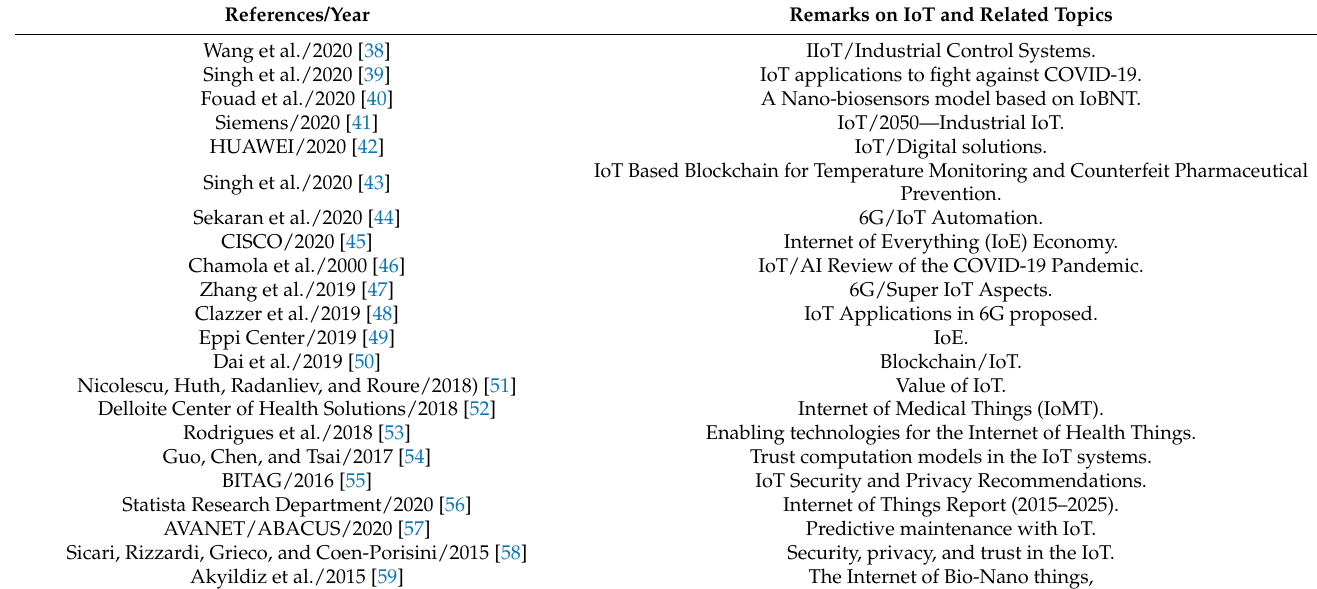
Table 3. Summary of the literature review on Internet of Things (IoT) and related topics.